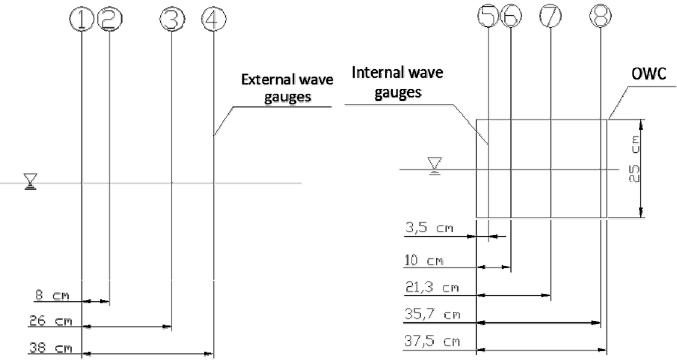
Figure 8. Location of the WGs inside the chambers and outside the device.